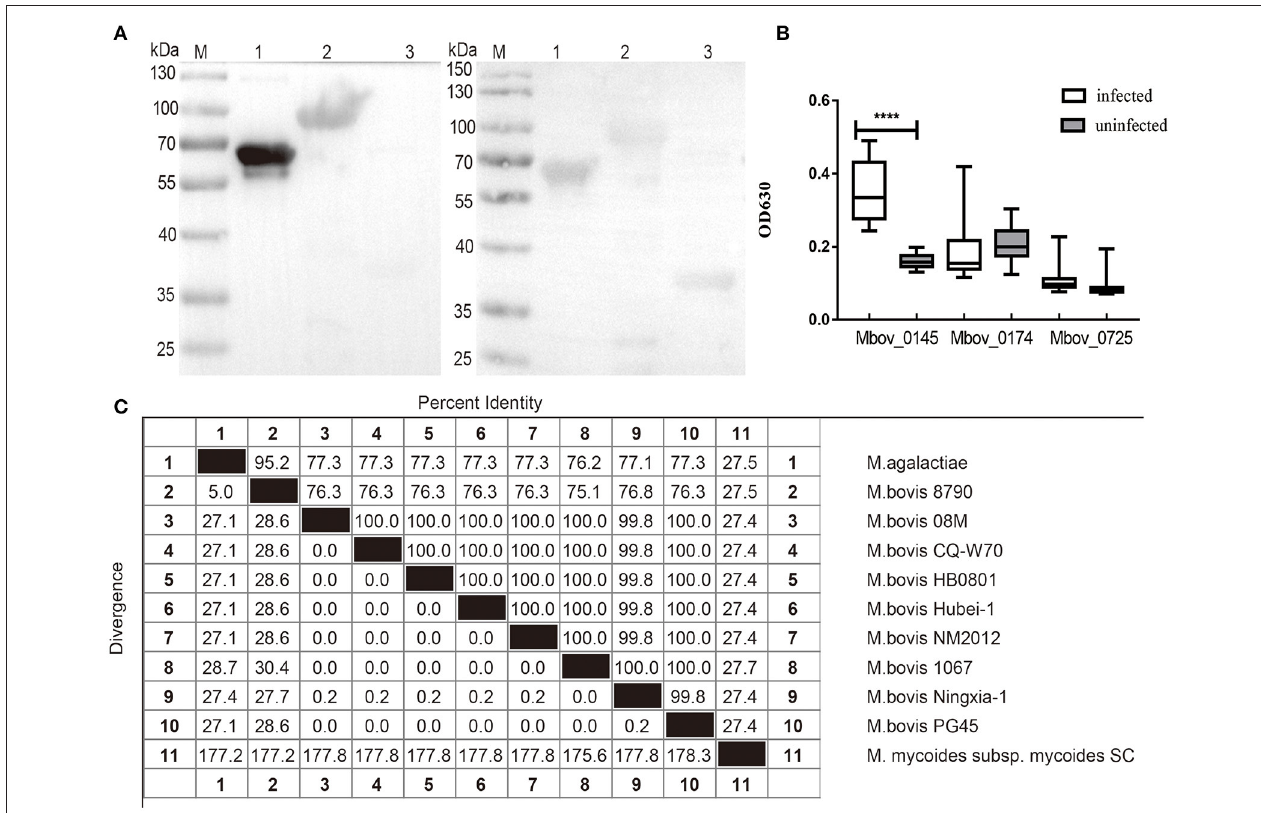
FIGURE 6 | Evaluation of the reaction of rMbovP0145, rMbovP0174, and rMbovP0725 with the pooled cattle sera positive and negative for Mycoplasma bovis infection. (A) Western blotting detected the reaction of the recombinant proteins with the pooled sera (diluted 1:100) from 15 M. bovis infected and 15 uninfected calves. M, protein marker; lane 1, MbovP0145; lane 2, MbovP0174; lane 3, MbovP0725. (B) iELISA tests of the reaction of the recombinant proteins with individual serum samples (diluted 1:100) from 15 M. bovis infected and 15 uninfected calves. The horizontal solid lines for each group indicate the median values; **** p < 0.0001. (C) Amino acid sequence identity (%) of MbovP0145 sequences among Mycoplasma species in this study. Their respective Genebank accession numbers are as follows: Mycoplasma agalactiae (WP_041308700.1), M. bovis 8790 (TKA58782.1), M. bovis 08M (WP_013954588.1), M. bovis CQ-W70 (AIA33730.1), M. bovis Hubei-1(AEI89852.1), M. bovis NM2012 (WP_013954588.1), M. bovis 1067 (TKA60039.1), M. bovis Ningxia-1 (WP_141790766.1), M. bovis PG45 (WP_080551560.1), and M. mycoides subsp. mycoides SC